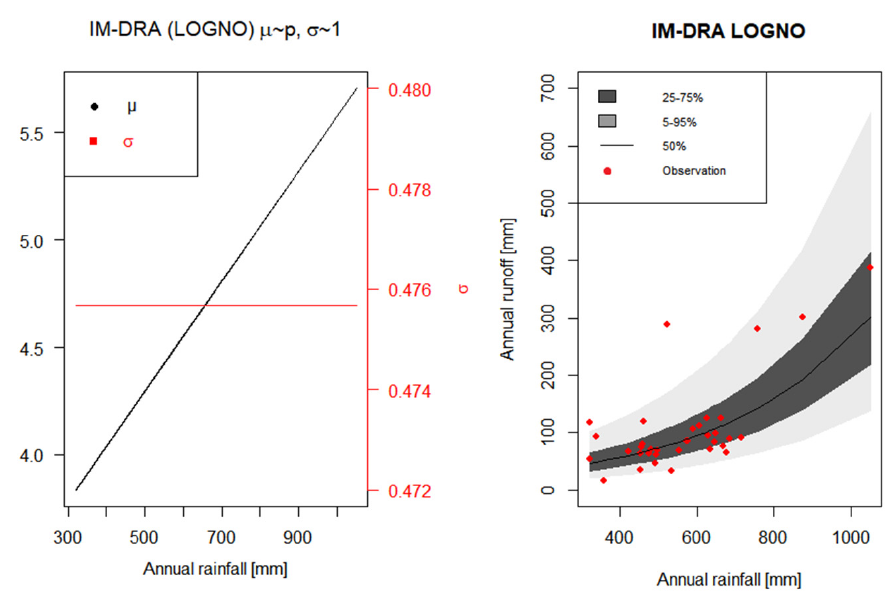
Figure 5. Variation of µ and σ parameters with annual rainfall for the IM-DRA LOGNO distribution ( left panel ) and the centiles plot ( right panel ) for the same station, along with the plot for annual runoff vs. annual rainfall.